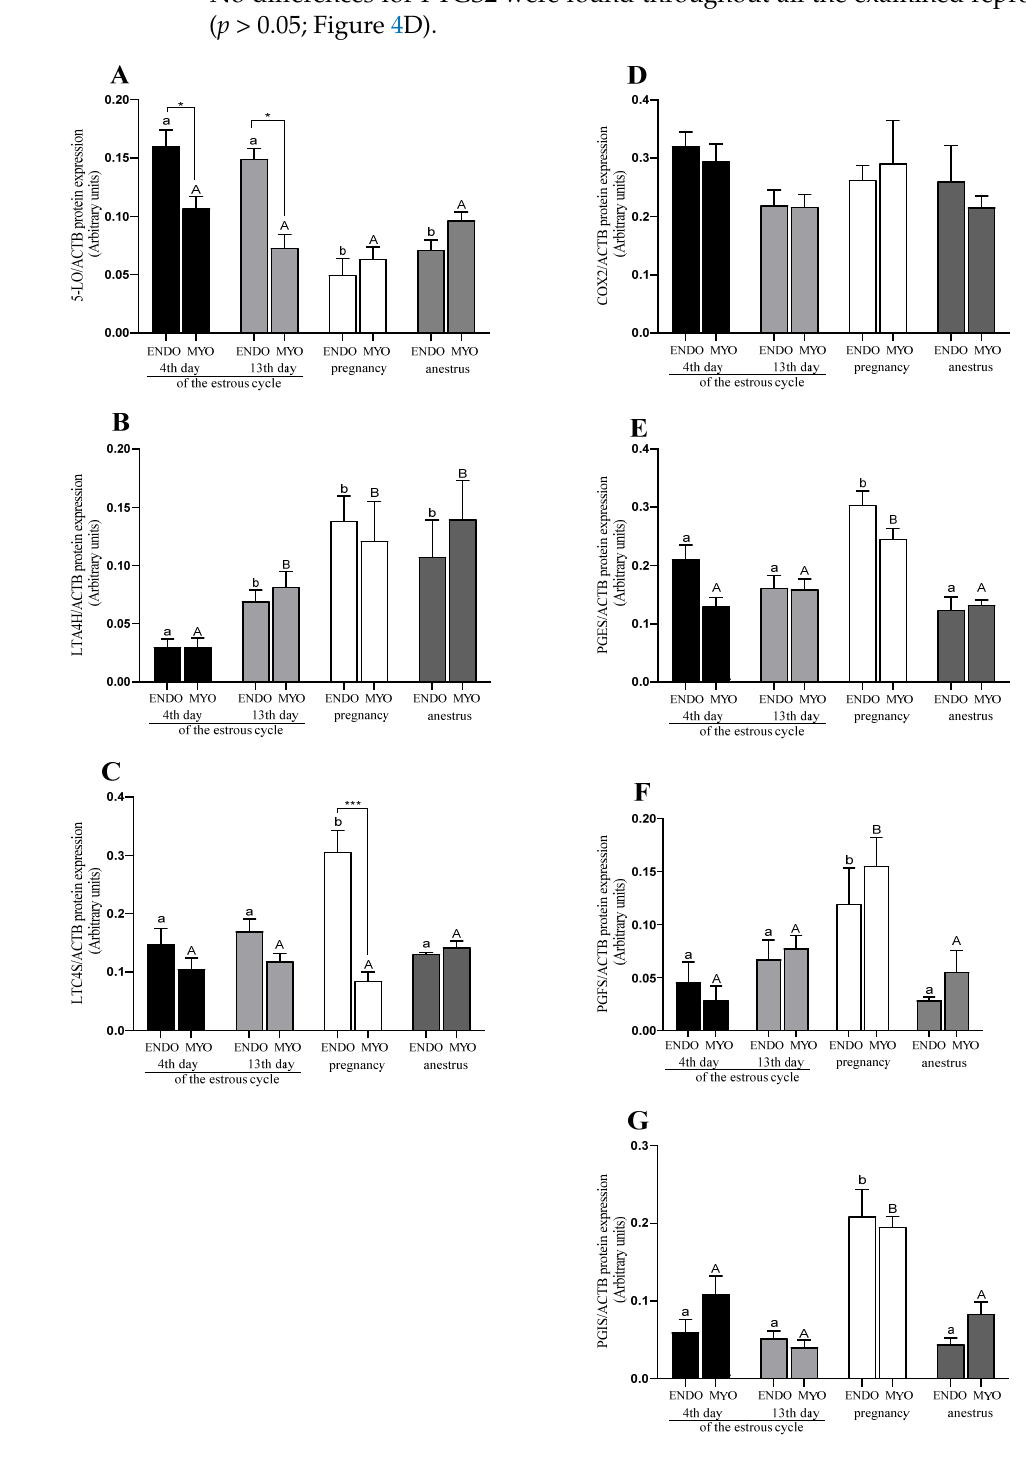
Figure 4. Protein expression of 5-LO ( A ), LTA4H ( B ), LTC4S ( C ), PTGS2 ( D ), PGES ( E ), PGFS ( F ), and PGIS ( G ) in uterine tissues (endometrium and myometrium) on 4th and 13th day of the estrous cycle, and in pregnancy and anestrus phase. Data were normalized against ACTB for protein ex- pression using GraphPad PRISM (Version 8.3.0). Each bar represents one experimental group with SEM. Statistical differences were analyzed with two-way analysis (ANOVA) of variance followed by Tukey’s post hoc test. The lowest statistical significance was p < 0.05. Asterisks indicate statistical differences between endometrium and myometrium (* p < 0.1; *** p < 0.001). Different letters indicate